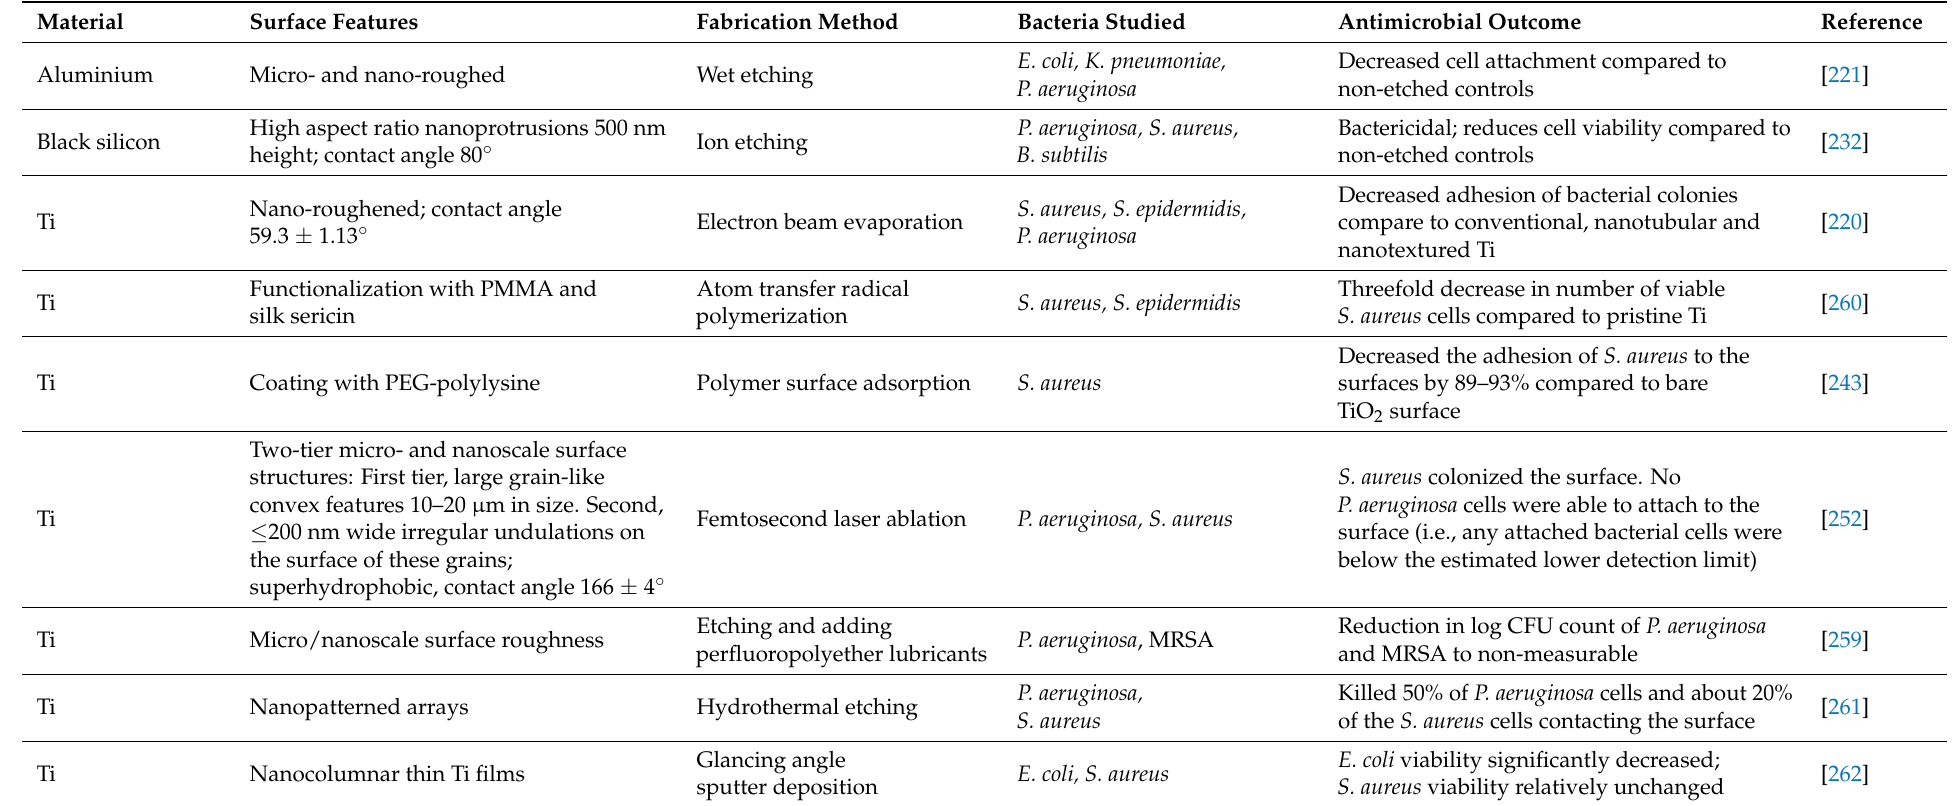
Table 4. Surface feature, drug-free engineering approaches to impede microbial infection in orthopaedic implants. The table highlights surface features, fabrication method and antimicrobial